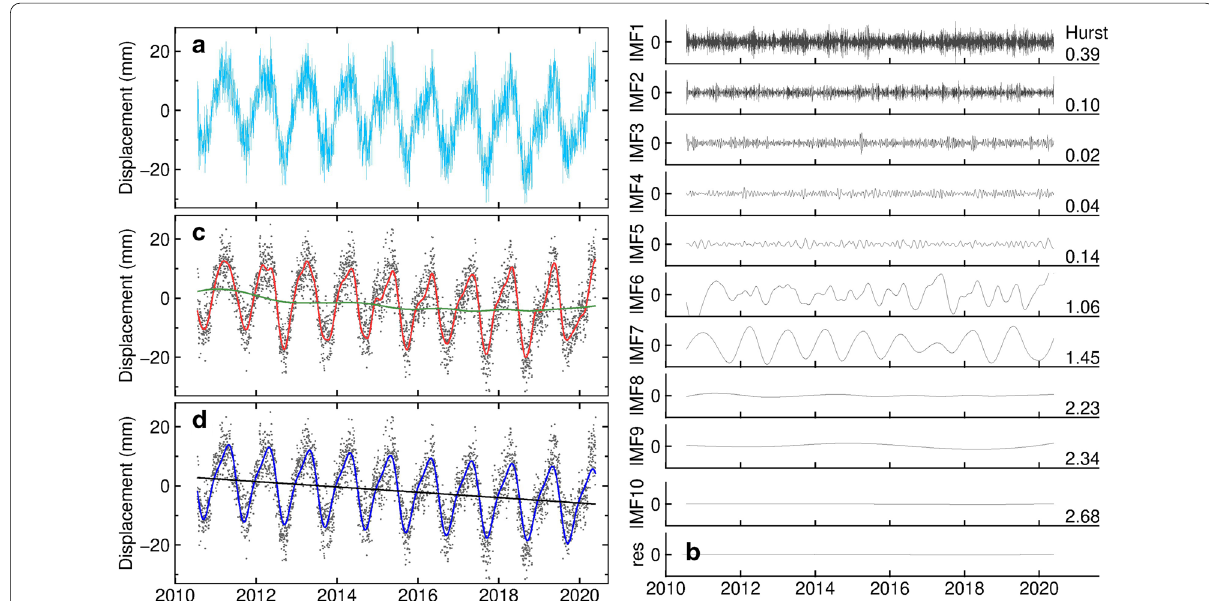
Fig. 2 Vertical coordinate time series at the YNRL station. a Raw time series; b intrinsic mode functions (IMFs) decomposed by ensemble empirical mode decomposition (EEMD); c reconstructed deformation signal. Gray point, red curve, and green curve denote GPS daily solution, reconstructed seasonal and trend signal, respectively. d Modeled result. Gray point is GPS daily solution, blue curve shows filter results using the linear annual-cycle semi-annual-cycle movement model, and black line is the linear trend + +